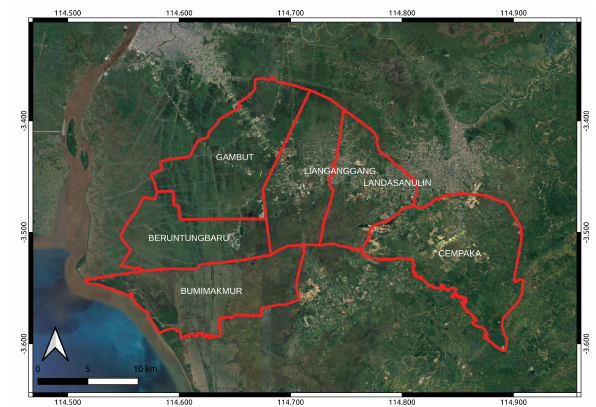
Figure 1. Location of the study area in Banjar Regency and Banjarbaru City, South Kalimantan, Indonesia. Source of satellite images: Google